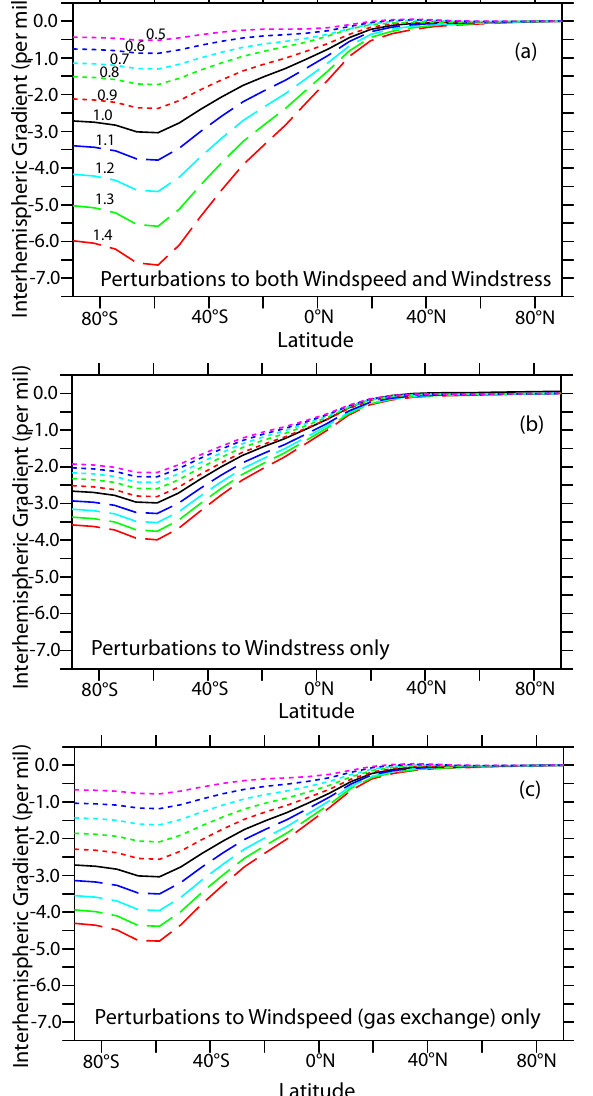
Fig. 5. Response of zonal surface 1 14 C to Southern Ocean wind perturbations (per mil deviations from value at North Pole for each case). (a) Perturbation applied to both wind stress (dynamical forc- ing) and wind speed (gas exchange). (b) Perturbation applied to wind stress (but not gas exchange). (c) Perturbation applied to gas exchange (but not wind stress).